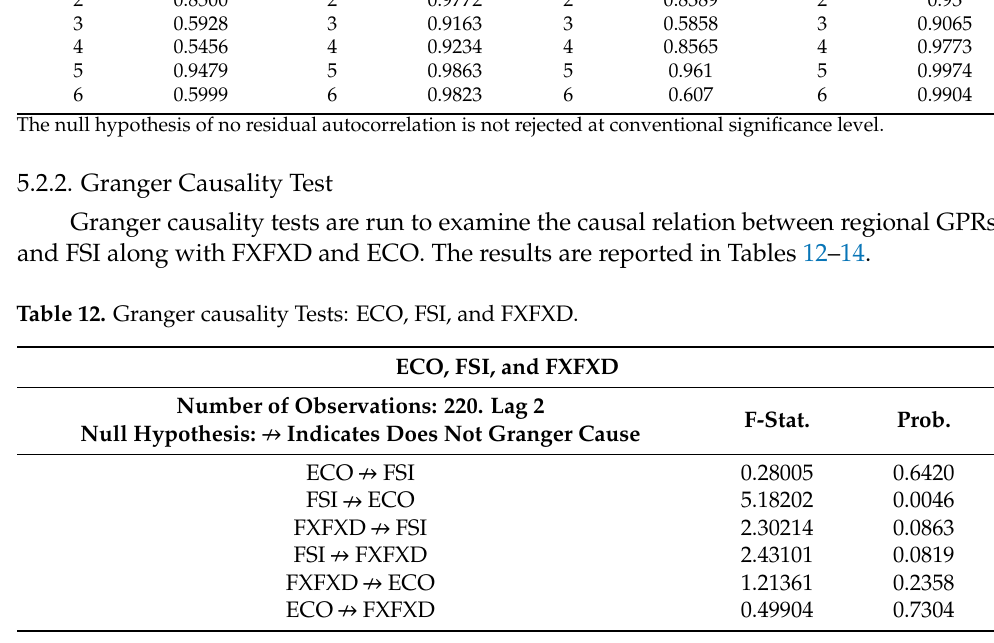
Table 11. VAR residual serial correlation with one GPR.